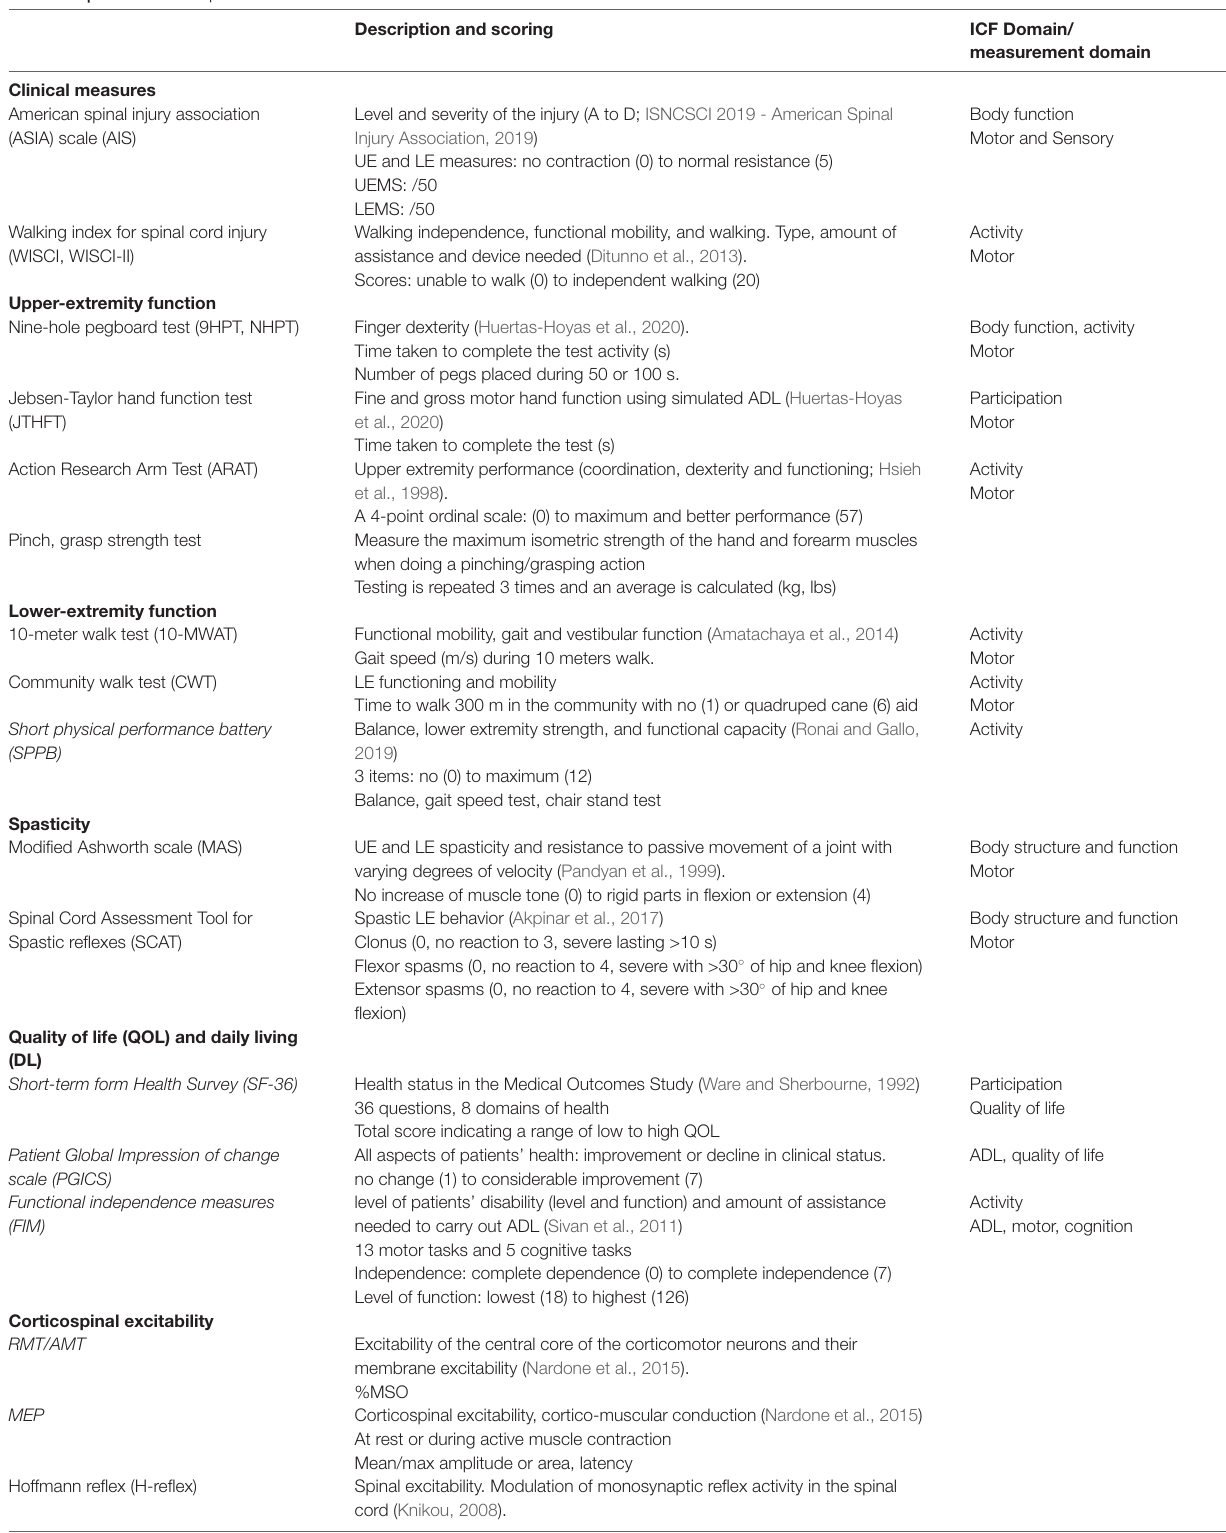
TABLE 2 | List and description of the outcomes and measures used in the rTMS studies. Description and